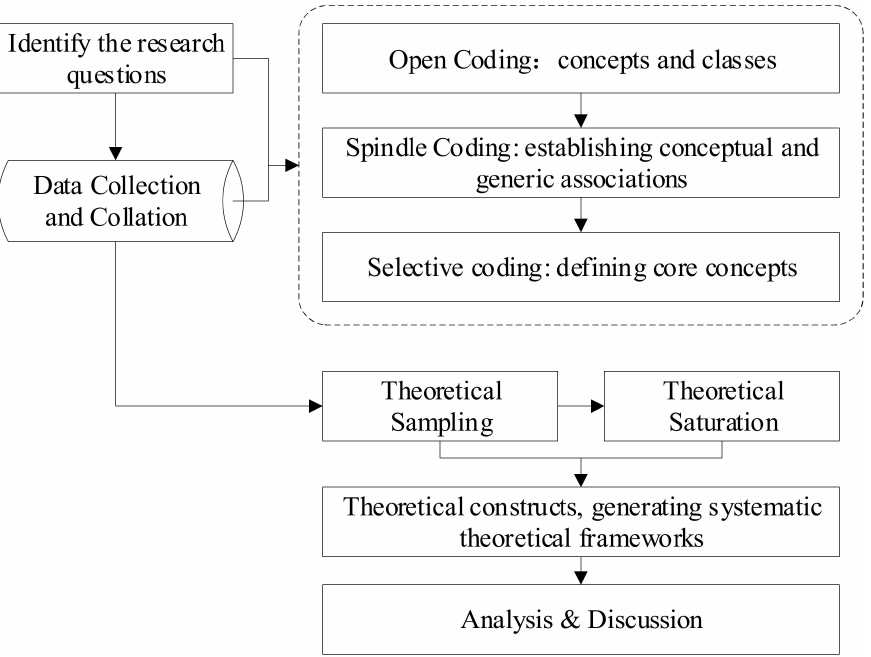
Figure 1. Process of rooting